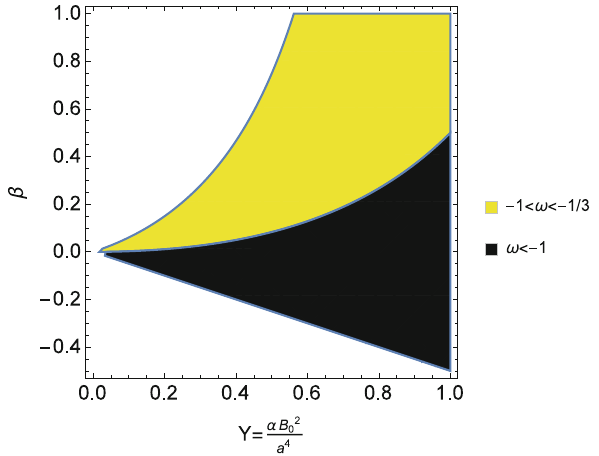
Fig. 1 Are presented the regions which gives acceleration in the plane Y = α B vs. β